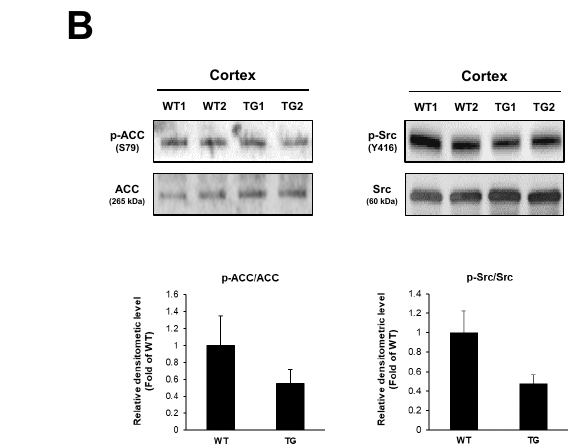
Figure 6. Western blots for phosphorylation of the proteins in 5xFAD mice brain. ( A ) Western blot of phosphorylation of acetyl-CoA carboxylase and Src in the hippocampus of 5xFAD mice brains. ( B ) Western blot of phosphorylation of acetyl-CoA carboxylase and Src in the cortex of 5xFAD mice brains. Tissue lysates were electrophoresed and blotted. WT and TG indicate wild-type and 5xFAD mice,